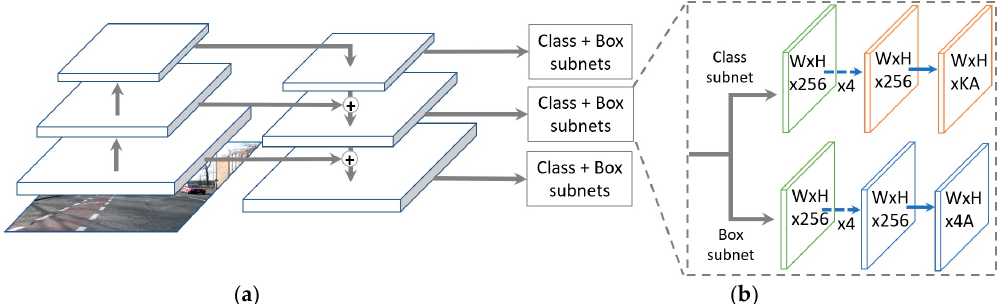
Figure 4. Architecture of RetinaNet: ( a ) to produce the multi-scale convolutional feature pyramid using a residual network (ResNet) as an encoder (left) and a feature pyramid net (FPN) as a decoder (right). ( b ) Class subnet for classifying anchor boxes (top), and box subnet for regressing from anchors boxes to ground-truth object boxes (bottom).